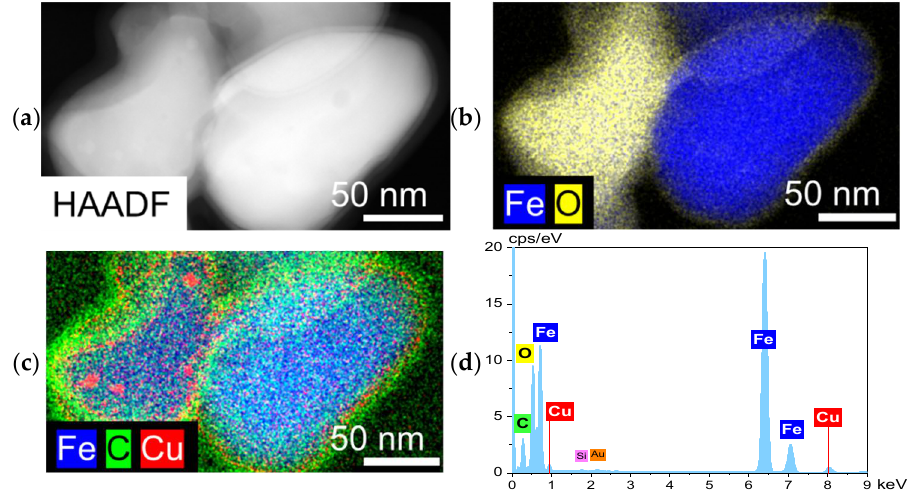
Figure 5. ( a ) STEM-HAADF of spent 5%-Cu/FeO x , and ( b – d ) EDX elemental mapping of Fe, O, C and Cu.